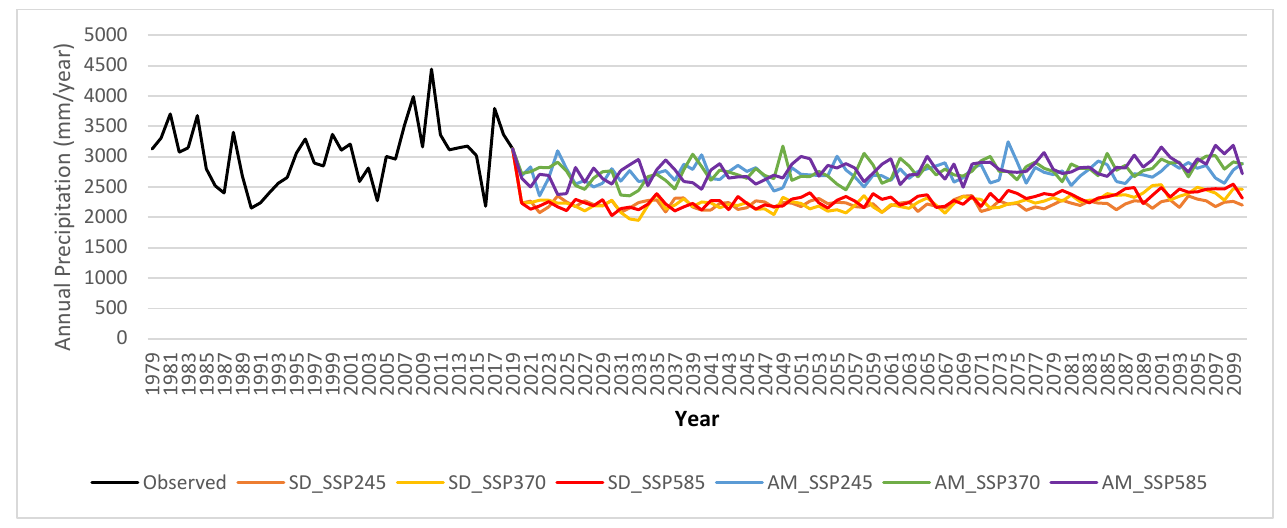
Figure 6. Annual Precipitation generated by SD and AM model relative to the observed precipitation. Table 5. Changes in future precipitation in comparison to observed mean of 3041.2 mm.